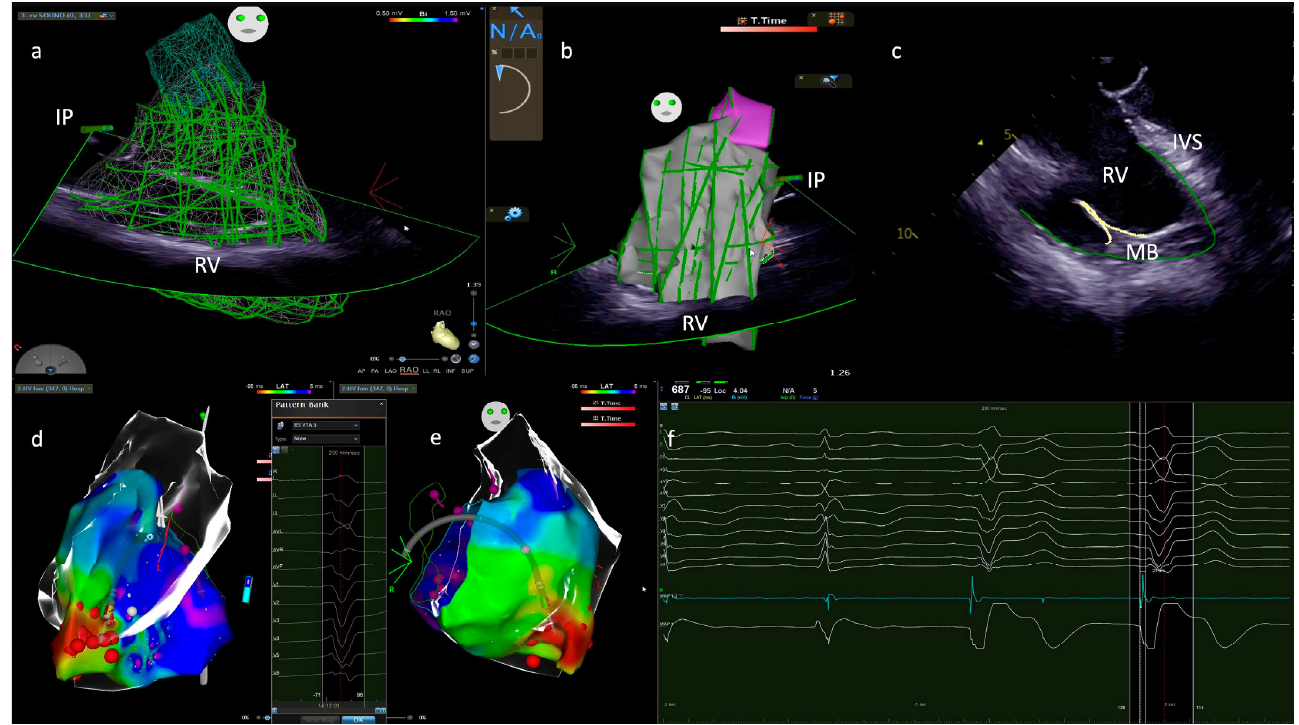
Figure 2. ( a ) Intracardiac echocardiography view; IP is in the right atrium in the right anterior oblique view; green lines paint the long and short axis of RV, constructing a 3D RV echo − map. ( b ) same image in the left anterior oblique view; ( c ) two − dimensional view of RV. The green lines trace the endocardial surface, and yellow lines the MB; ( d ) Merge of the 3D echo map and activation map of PVC in lateral view; ( e ) PVC activation map in right anterior oblique view; ablation at the earliest activation site on the MB using an electroanatomic mapping system; the red color on the activation map is the earliest activation site; the red bullets are the RF lesion tagged points; ( f ) electrogram PVC potential; sharp and QS unipolar signal and adequate PVC anticipation. IP: intracardiac probe; RV: right ventricle; MB: moderator band; 3D: three dimensional; PVC: premature ventricular complex; RF: radiofrequency.